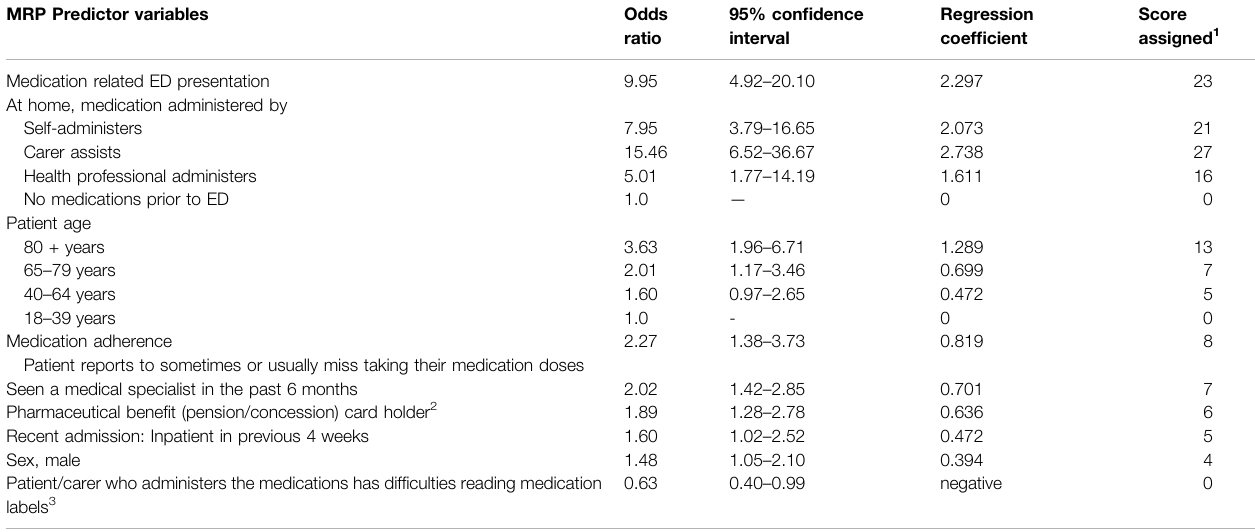
TABLE 2 | ED Presentation Screening Tool: summary of multivariable regression analysis of predictor variables for medication-related problems that could be identi fi ed/ managed/prevented by screening early in the ED presentation (n = 904). MRP Predictor variables Odds